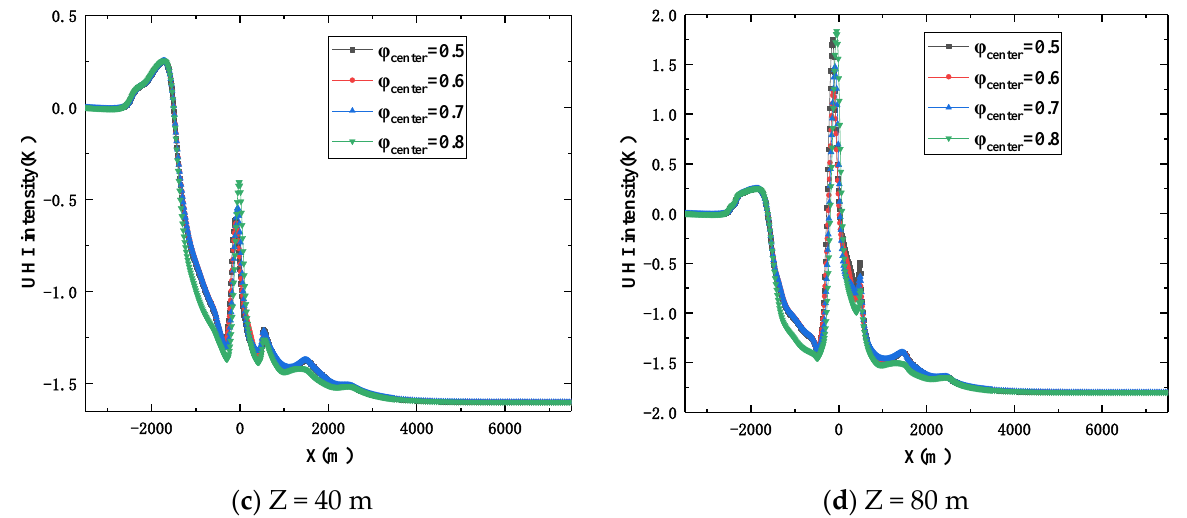
Figure 12. The horizontal profiles of the UHI intensities at different porosities in the central business district at the height of ( a ) 2 m, ( b ) 10 m, ( c ) 40 m, and ( d ) 80 m in the plane y = 0.